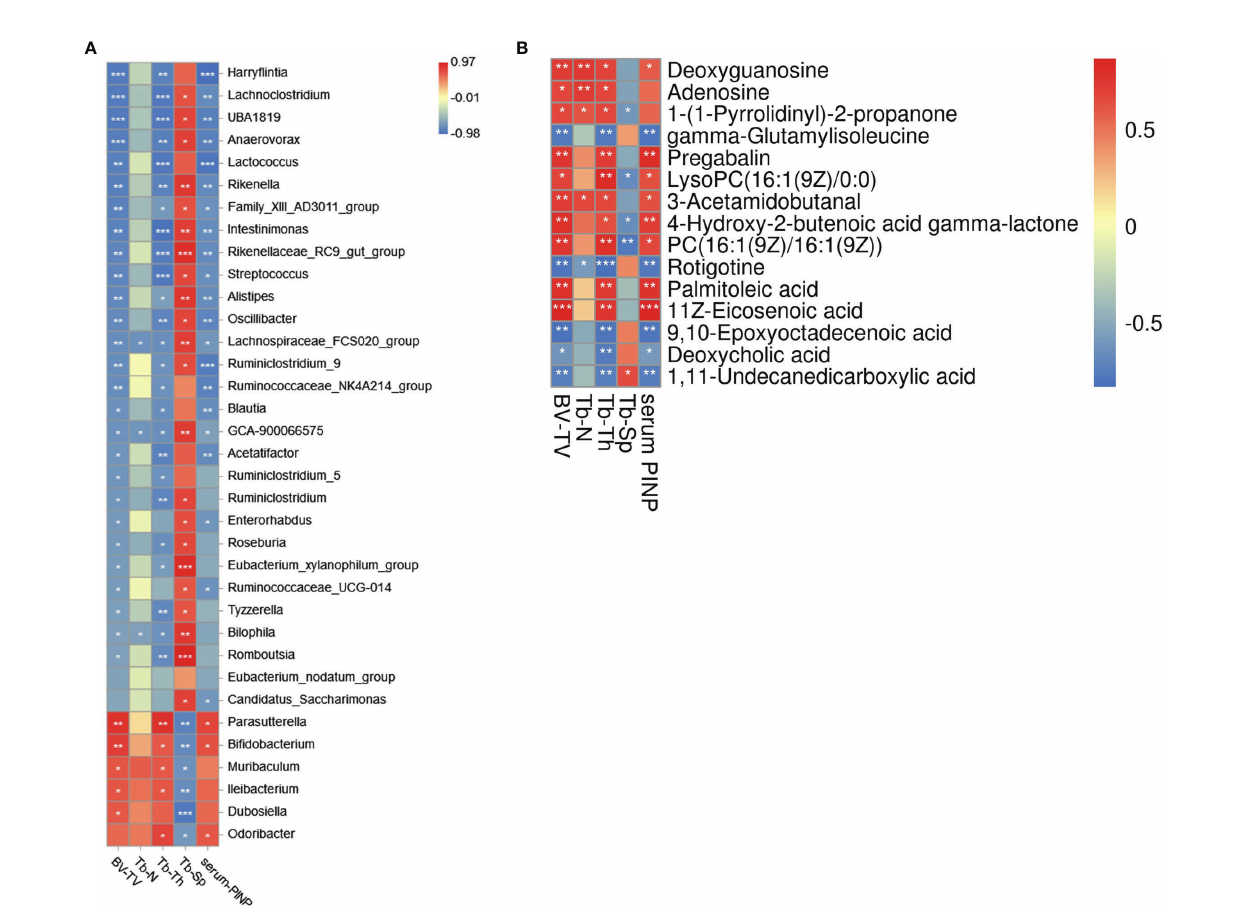
FIGURE 5 | Association analysis of gut microbiota, bone phenotypes, and serum metabolome. (A) The heat map of Spearman rank correlation coef fi cients between the GM and bone phenotypes (|r|>0.6). (B) The heat map of Spearman rank correlation coef fi cients between the serum metabolites and bone phenotypes. * P < 0.05, ** P < 0.01, *** P <